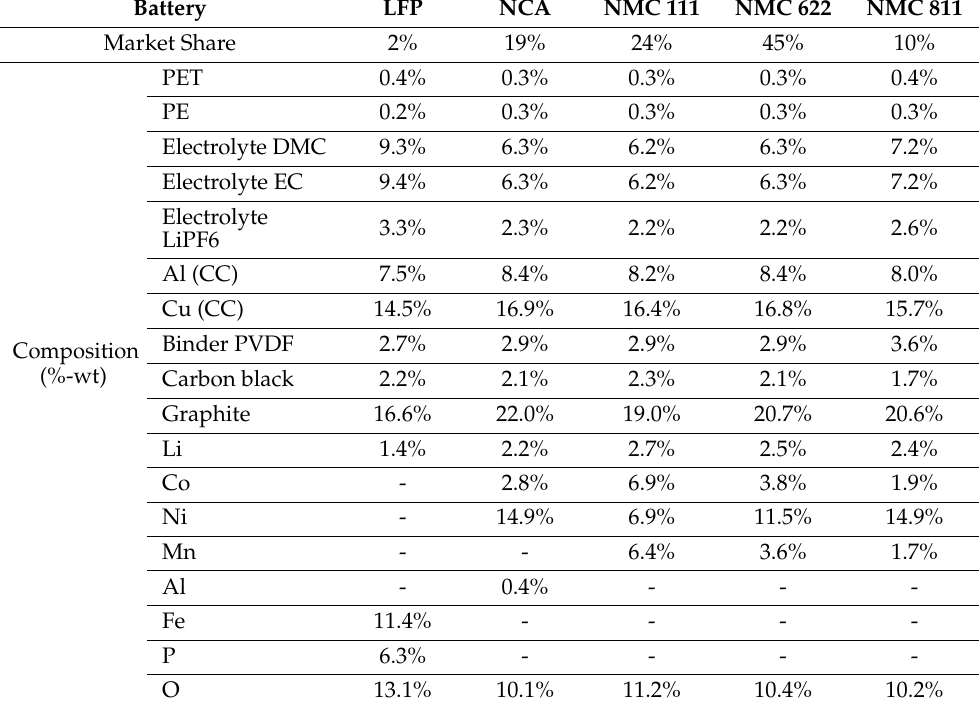
Table 1. Market shares and compositions of the LIBs (identified by the different cathodes) considered in this study (CC: current collector; DMC: dimethyl carbonate; EC: ethylene carbonate; LFP: lithium